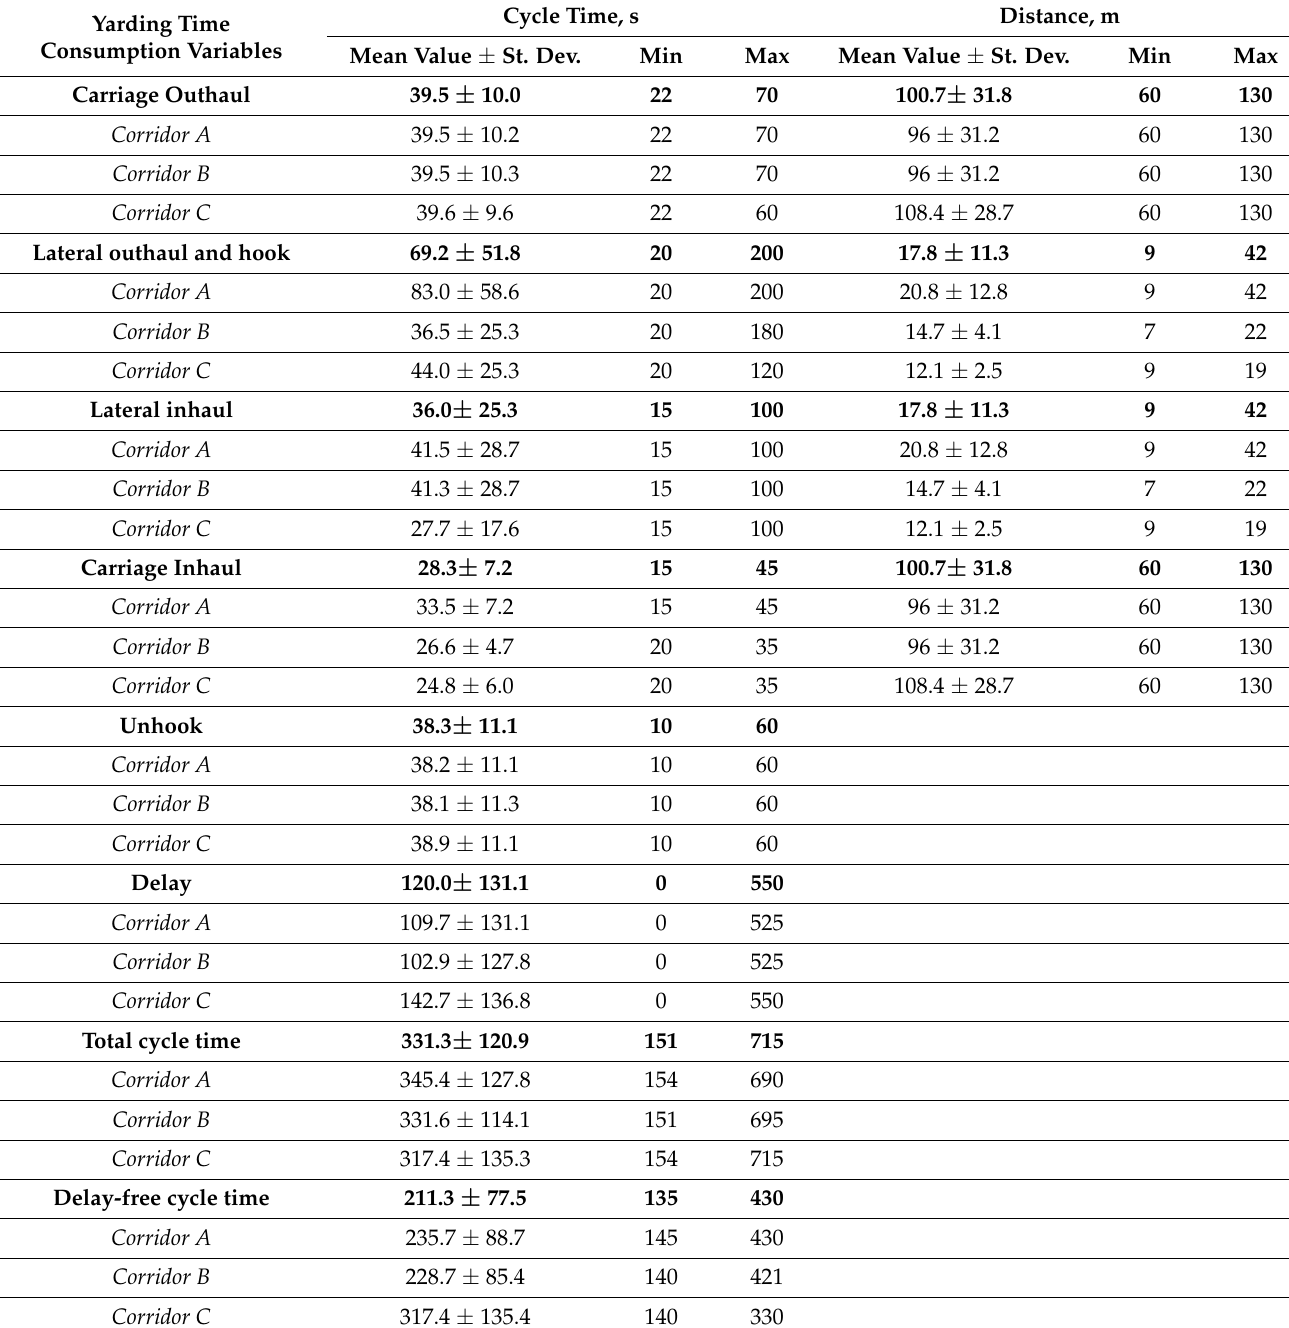
Table 3. Descriptive statistics of the time consumption and operational